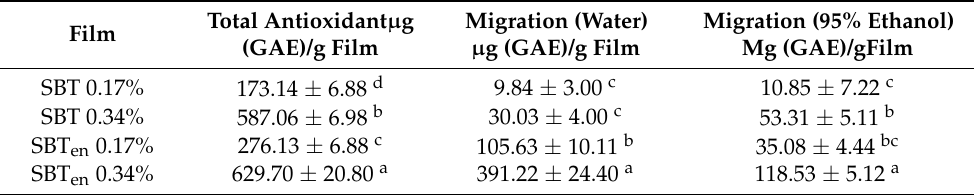
Table 2. Antioxidant content and their migration into food simulants (water and 95% ethanol), expressed in terms of µ g (gallic acid equivalent; GAE)/g